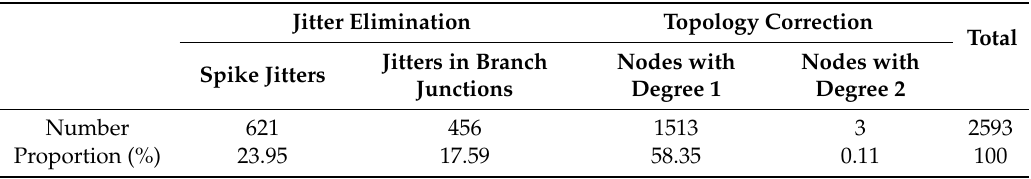
Table 1. Statistics of jitter elimination and topology correction in the experimental region.